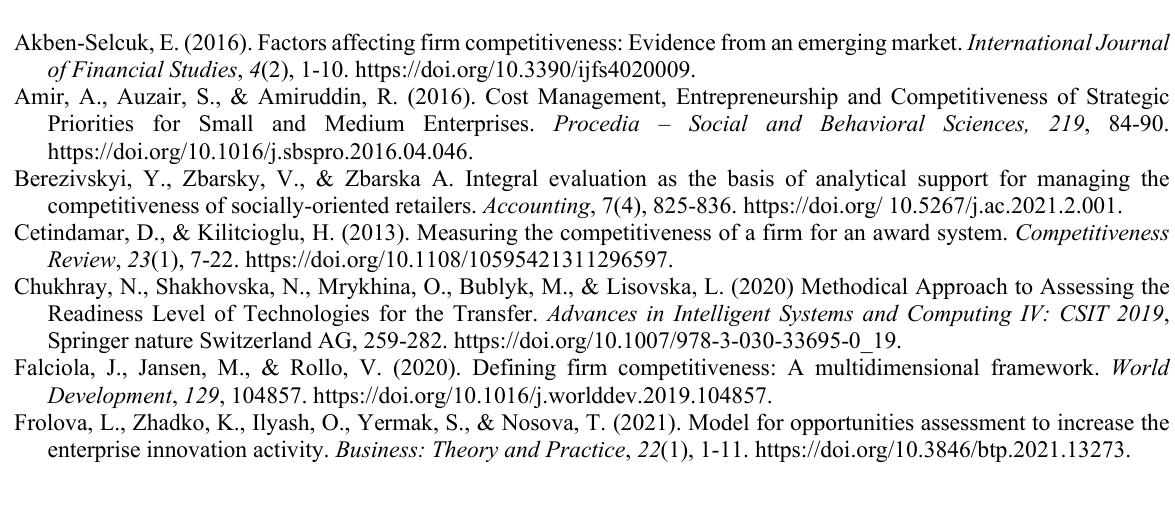
Expert method of assessment Analytical assessment Graphical